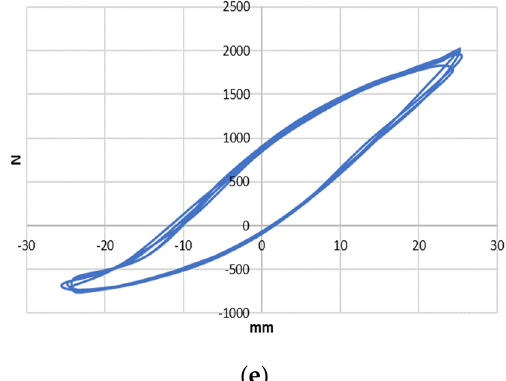
Figure 3. Force-displacement hysteresis loops, with the applied velocity of the maximum rated velocity at ( a ) 1%, ( b ) 25%, ( c ) 50%, ( d ) 75% and ( e ) 100%. Table 2. The normalized force vs. normalized velocity.